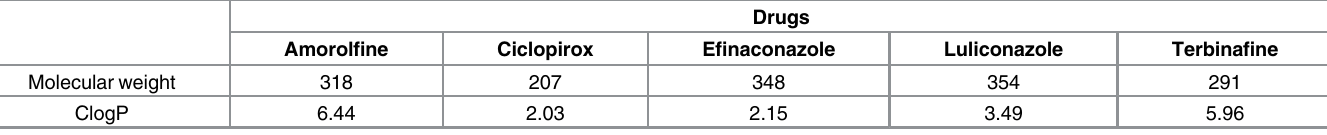
Table 1. Physical properties of five test